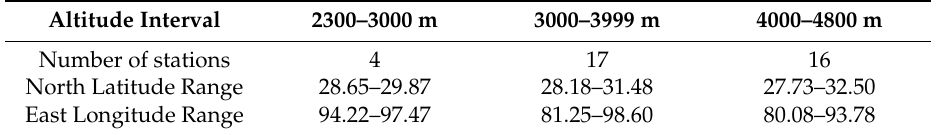
Table 6. Division of the stations into altitude intervals and their latitude and longitude ranges.